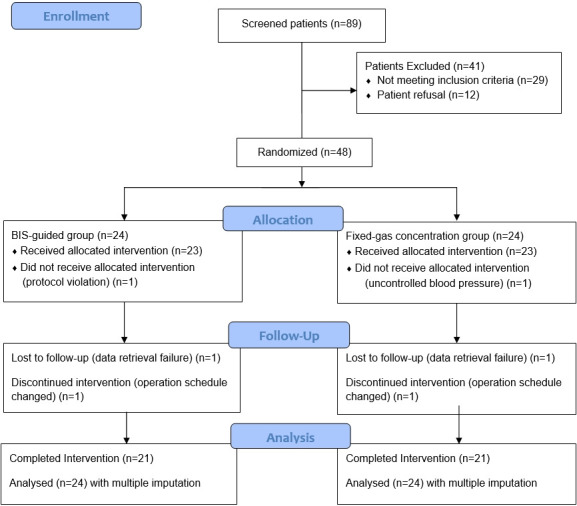
CONSORT diagram.